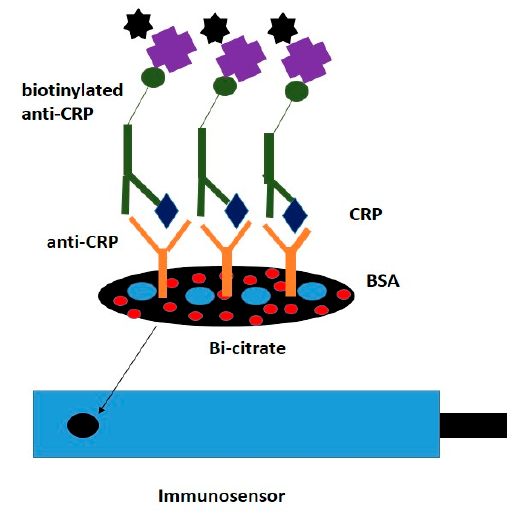
Figure 4. Sandwich-type immunoassay on a modified SPE Figure 4. Sandwich ‐ type immunoassay on a modified SPE [62].